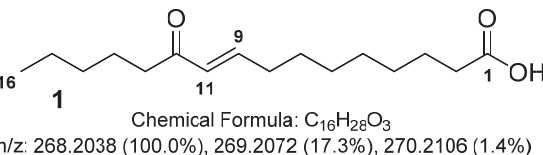
Figure 1. Structure of 11-oxopalmitelaidic acid ( 1 ). Table 1. 13 C (150 MHz) and 1 H (600 MHz) NMR data of compound 1 in CD 3 OD. Position δ C, mult.